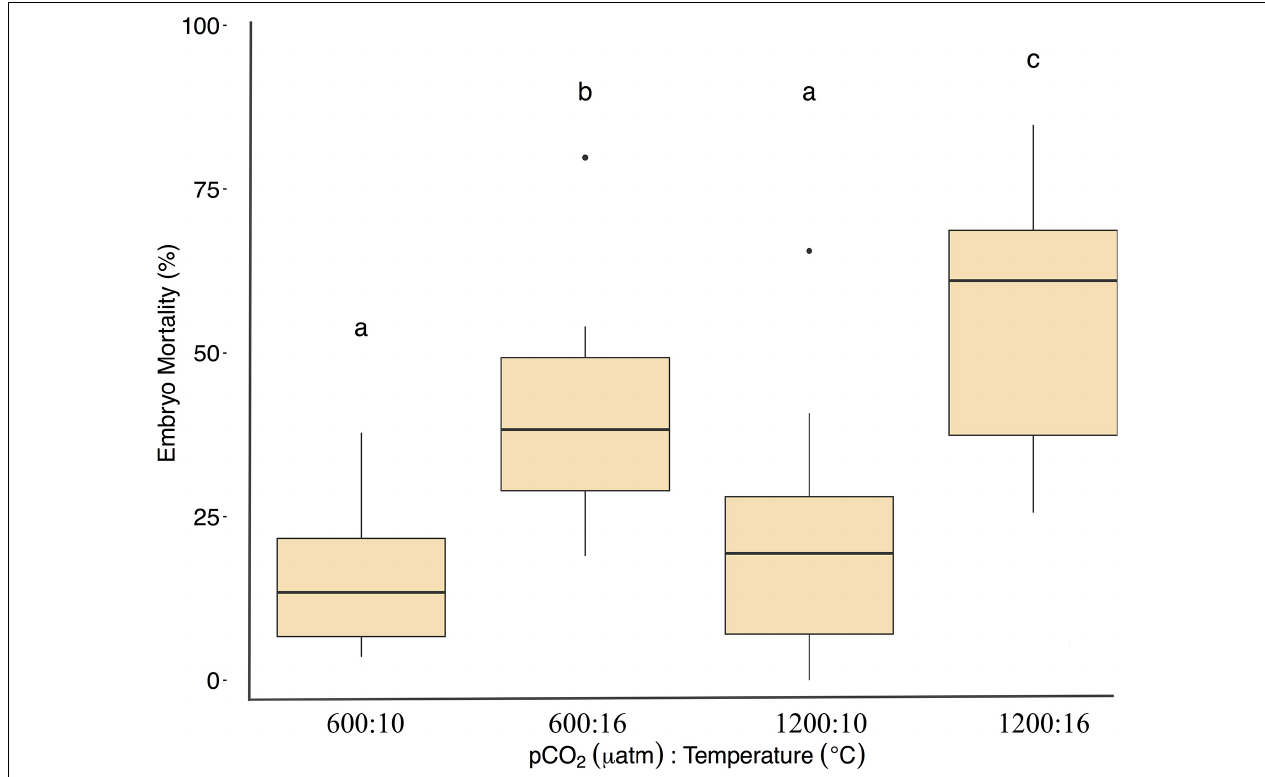
FIGURE 1 | Treatment effects on Pacific herring hatching success. Data represent the mean ± 1 SD of the percentage per slide, with 12 slides per 3 basins for each treatment. Lower-case letters indicate statistically different treatments based on a Tukey’s HSD post hoc comparison.